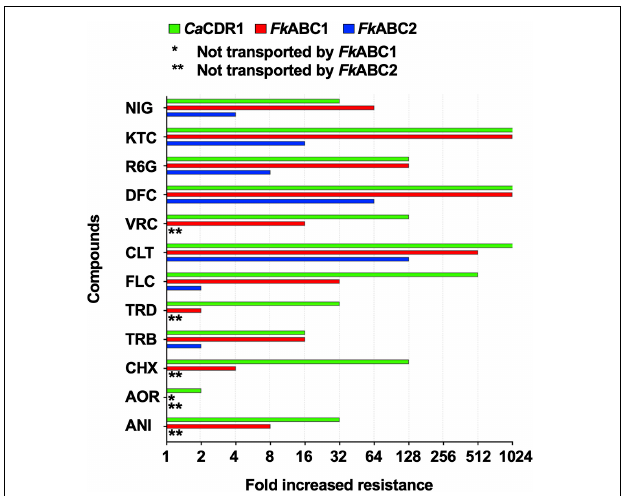
FIGURE 6 | Quantification of drug resistance levels of S. cerevisiae AD (cid:49)(cid:49) cells overexpressing CaCDR1 (green), FkABC1 (red), or FkABC2 (blue). The increased drug resistance levels ( x -axis) of 10 test compounds ( y -axis) were expressed as fold increased MICs relative to the sensitive control strain, S. cerevisiae AD (cid:49)(cid:49) . The 12 test compounds are arranged, from bottom to top, according to their molecular weight (MW): ANI (MW = 265), AOR (265), CHX (281), TRB (291), TRD (292), FLC (306), CLT (345), VRC (349), DFC (406), R6G (479), KTC (531), and NIG (725). One (*) or two (**) asterisks indicate no transport by Fk Abc1 or Fk Abc2, respectively. MIC measurements were performed twice and gave identical values.